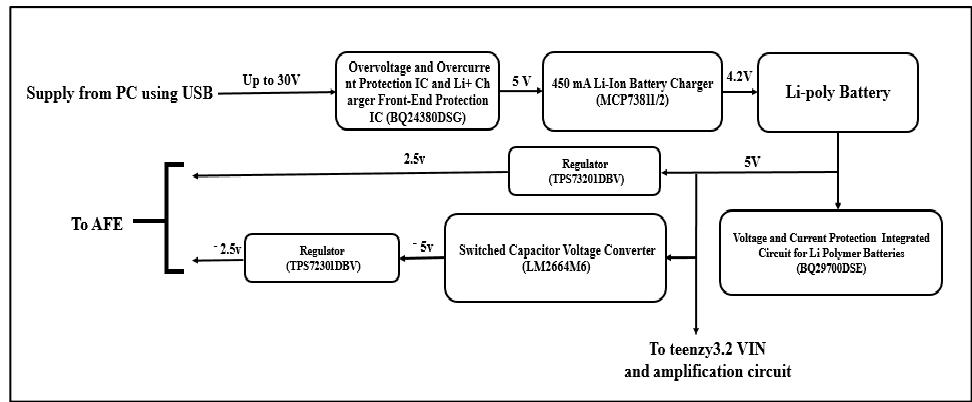
Figure 5. Block diagram of the overall power supply part.